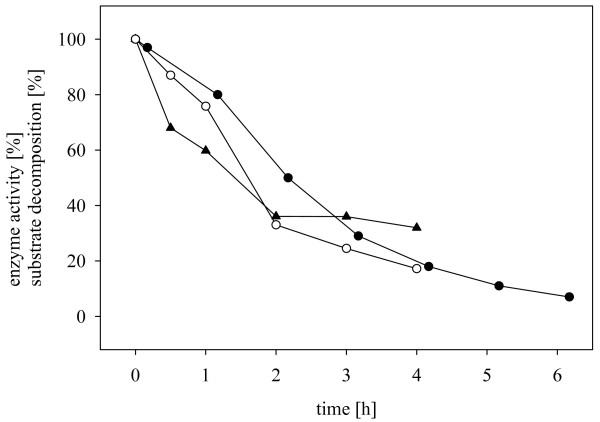
Inactivation of enzymes and spontaneous decomposition of substrate are limiting factors during whole cell-catalyzed reduction of ethyl 4-cyanobenzoylformate by E. coli XR_FDH. Inactivation: E. coli XR_FDH (40 gCDW/L) was incubated in the presence of 100 mM ethyl 4-cyanobenzoylformate and at the indicated times, enzyme activities were measured after cell disruption using B-Per (○ CtXR activity, ▲ CbFDH activity). Substrate decomposition: 100 mM ethyl 4-cyanobenzoylformate was incubated in potassium phosphate buffer 50 mM, pH 7.5, lacking cells, and the concentration of the compound was measured by HPLC in samples taken at the indicated times (●).